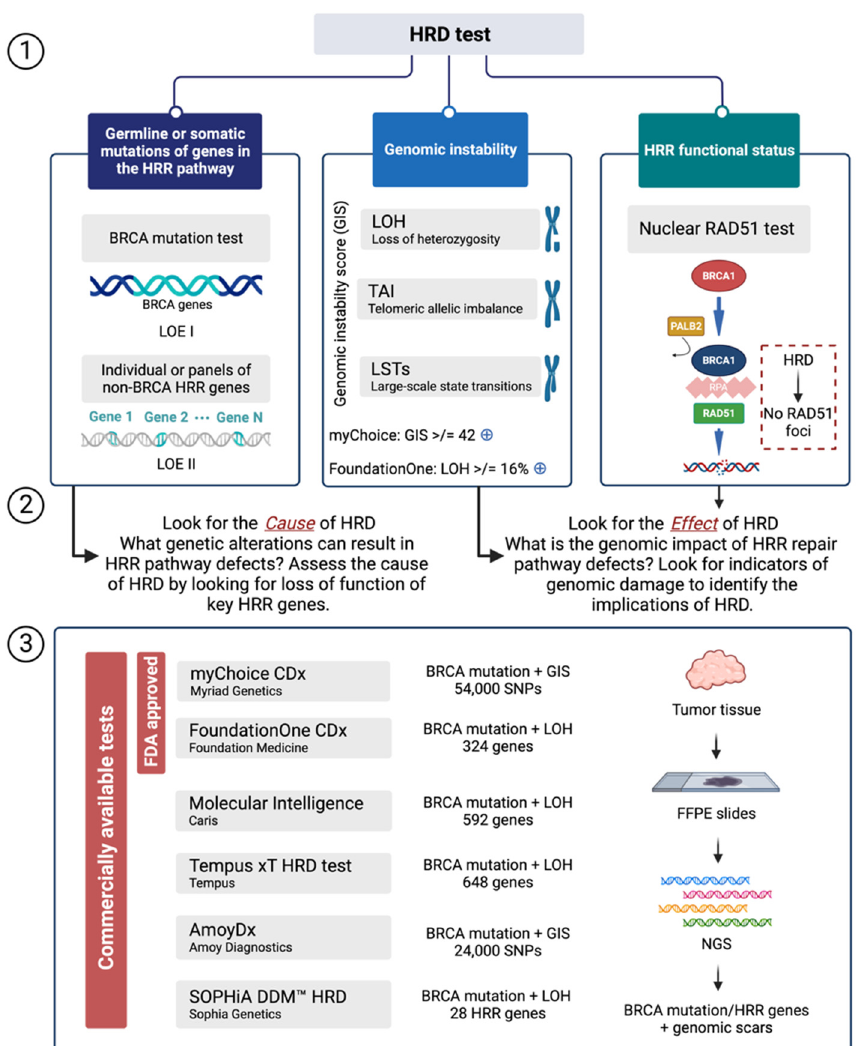
Figure 2. Approaches for testing HRD and commercially available assays. (1) HRD tests are classi- fied into three types: germline or somatic mutations of genes in the HRR pathway, genomic insta- bility, and HRR functional status testing. (2) There are two ways to detect HRD. The first is to look (LOE I) and individual or panels of non-BRCA HRR genes (LOE II). The alternative approach